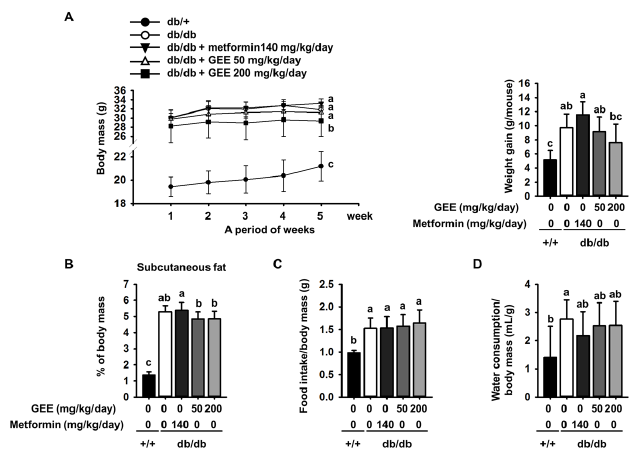
Figure 1. Effect of GEE on body mass ( A ); differences between time ‐ points and treatments were analyzed by two ‐ way ANOVA followed by Tukey’s multiple comparisons post hoc test. ( n = 8 per group). Effect of GEE on subcutaneous fat ( B ); food intake/body mass ratio ( C ); and water consumption/body mass ratio ( D ) in db/db mice. Data were analyzed by a one ‐ way ANOVA followed by Duncan’s test. Five ‐ week ‐ old mice were administered with or without GEE (50 and 200 mg/kg/day) for five weeks. Data are mean ± SD ( n = 8 per group, a p < 0.05, b p < 0.01, c p < 0.001)